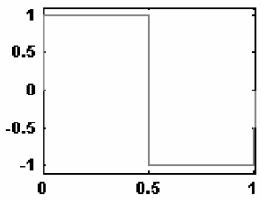
Figure 2. Haar wavelet (DB 1 ), which has a square shape; it is the simplest wavelet in the Daubechies family.